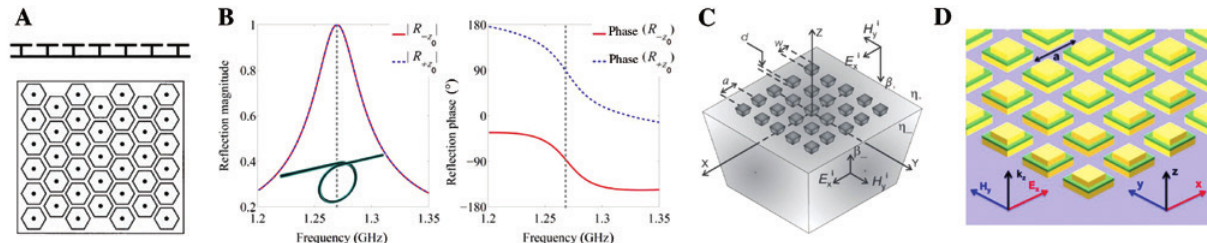
Figure 10: Metasurfaces for asymmetric co-polarized reflection. (A) Side and top views of a mushroom-type high-impedance surface possessing bianisotropic omega response. Reprinted figure from [130]. Copyright (1999) by IEEE. (B) The amplitudes (left) and phases (right) of co-polarized reflection coefficient for opposite illumination direc- tions of an omega metasurface. Due to the absence of a ground plane, the reflection coefficient reaches unit only at the resonance. The inset shows the metasurface unit cell with a metallic omega inclusion. Reprinted figure from [181]. Copyright (2014) by IEEE. (C) A planar array of plasmonic inclusions at the interface between two different media with characteristic impedances η impedances omega bianisotropic effects are induced in the metasurface with symmetric inclusions. Reprinted figure from [182]. Copyright (2015) by the American Physical Society. (D) Geometry of a plasmonic omega metasurface for asymmetric absorption of normally incident waves in the near infrared. Reprinted figure from [64]. Copyright (2015) by the American Physical